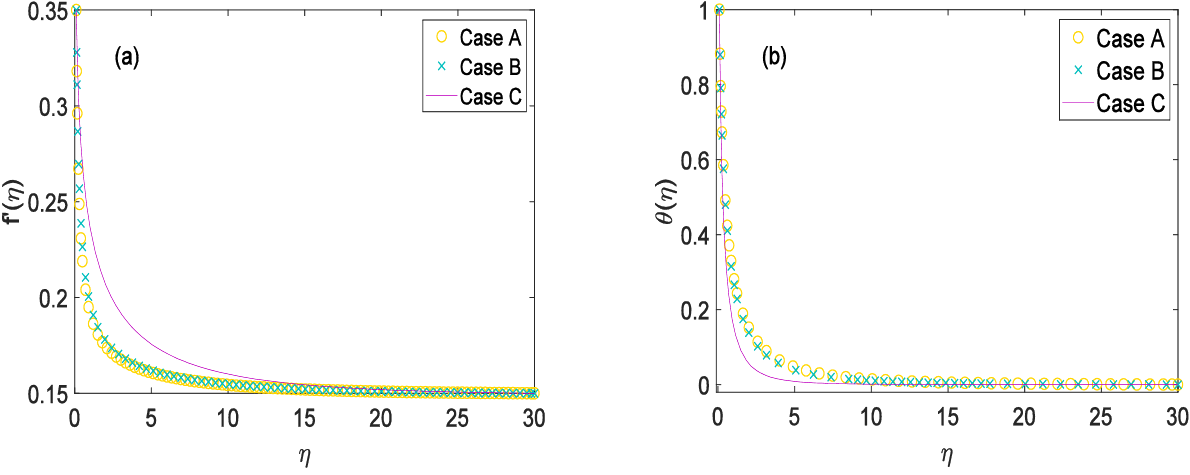
Figure 3. Comparison of velocity and temperature profiles for Case A (Exponential temperature dependent viscosity), Case B (Inversely linear temperature dependent viscosity) and constant fluid properties when the parameters are fixed at m = 0.1, Pr = 5, λ = 0.7, (cid:101) = 0.5, θ e = − 0.37 and θ w = 1.27. Part ( a ) shows function f (cid:48) , while the function θ is plotted in part ( b ). Figure 4a,b demonstrates the significance of parameter λ on the flow and heat transfer characteristics, respectively. Note that parameter λ = U w / ( U w + U ∞ ) measures the